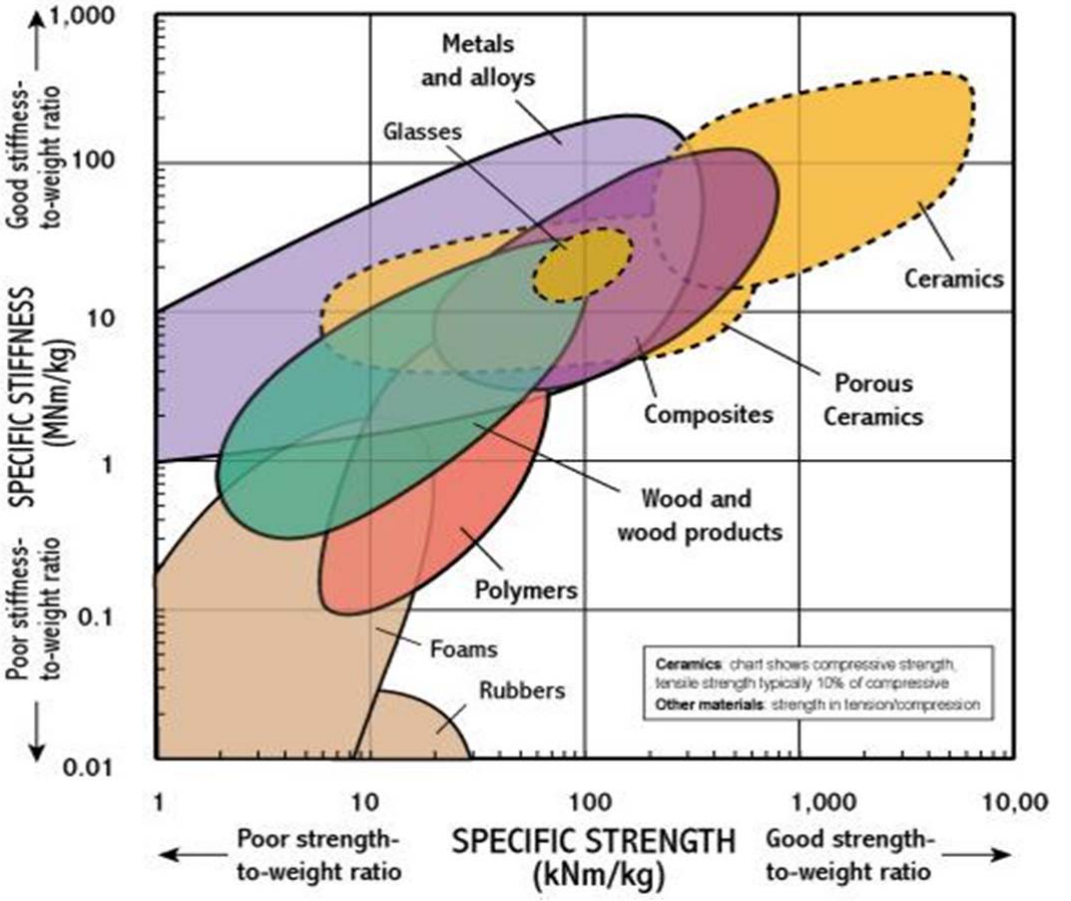
Figure 1. Comparison of stiffness and strength with a weight between composite materials